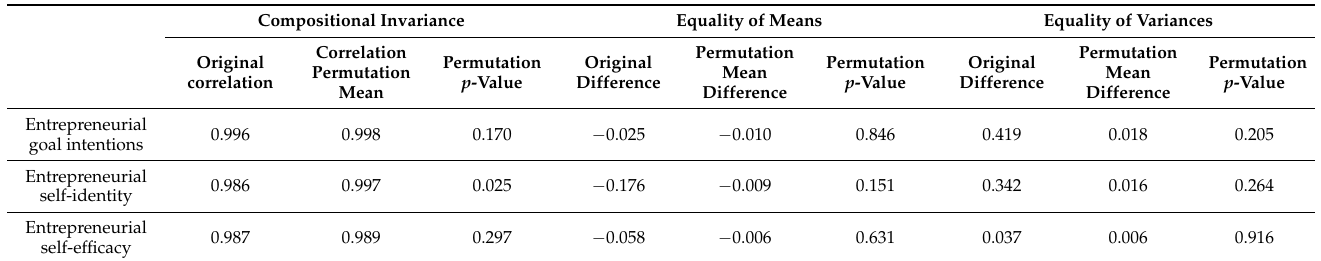
Table 6. MICOM test results.